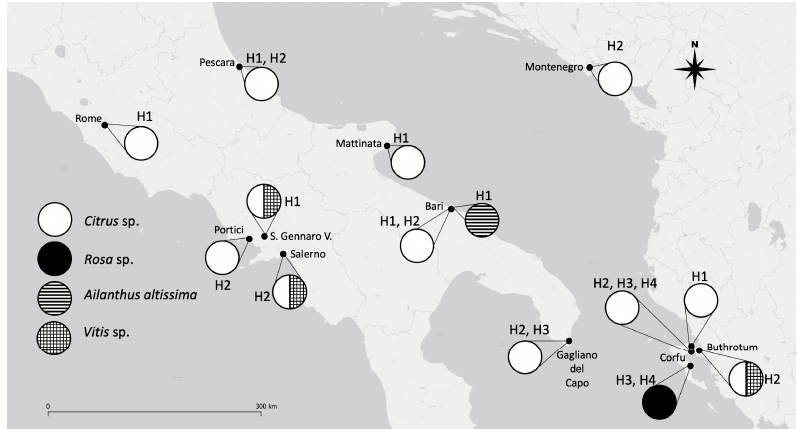
Figure 2. A. spiniferus distribution, mitochondrial haplotypes, and respective host plants in EPPO zone. EPPO, European and Mediterranean Plant Protection Organization areas.